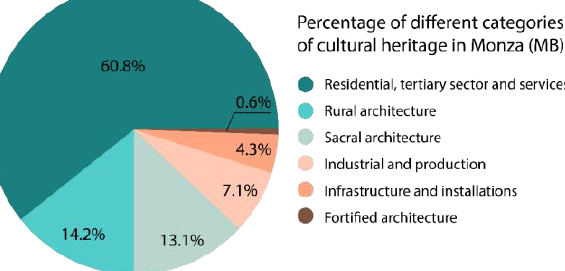
Figure 6. Pie chart made in Replit and exported as PDF file. Numerical values are presented in percentages (see Figure 4, source: D. Jovanović, second variation).